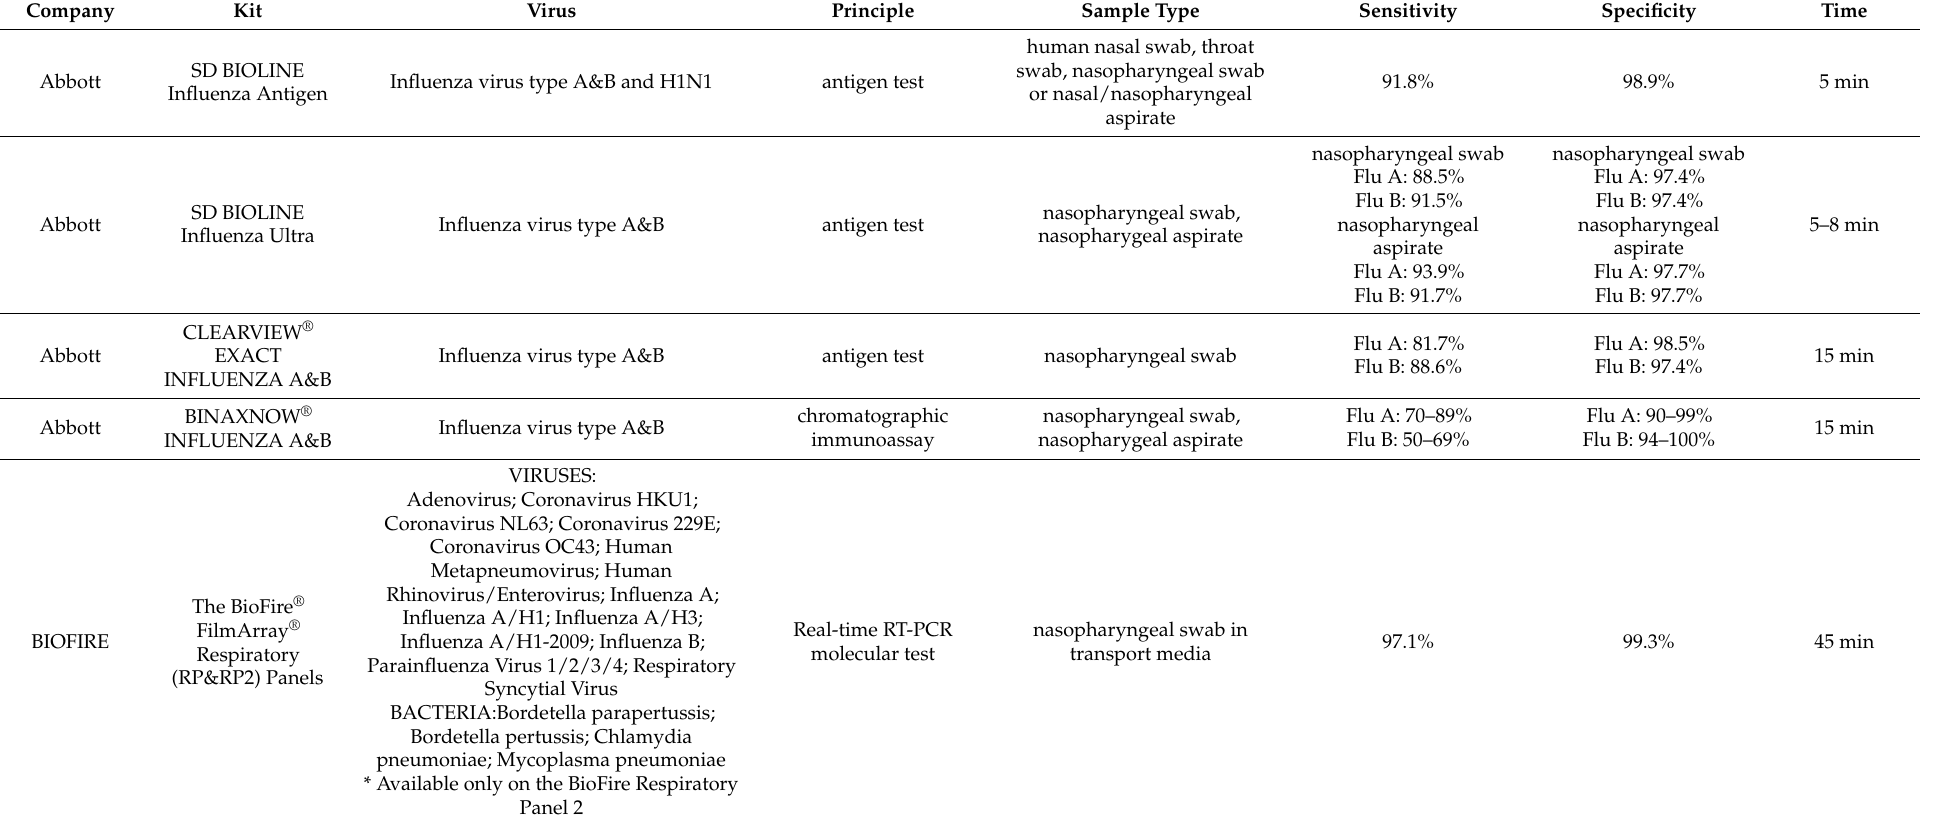
Table 2. Characteristics of commercial respiratory virus detection